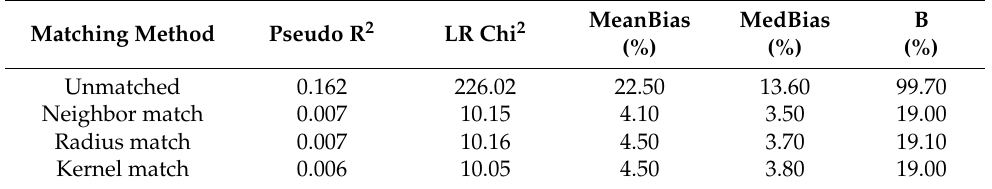
Table 8. Explanatory variable balance test results before and after matching.